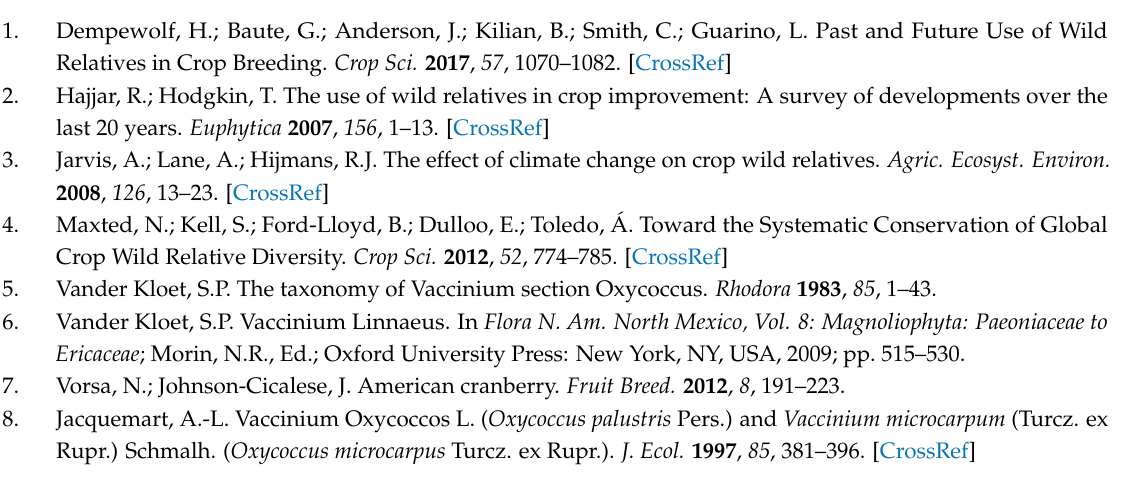
Supplementary File 1: Additional datasets; Figure S1: Coverage maps for mitochondrial genomes; Figure S2: Coverage maps for chloroplast